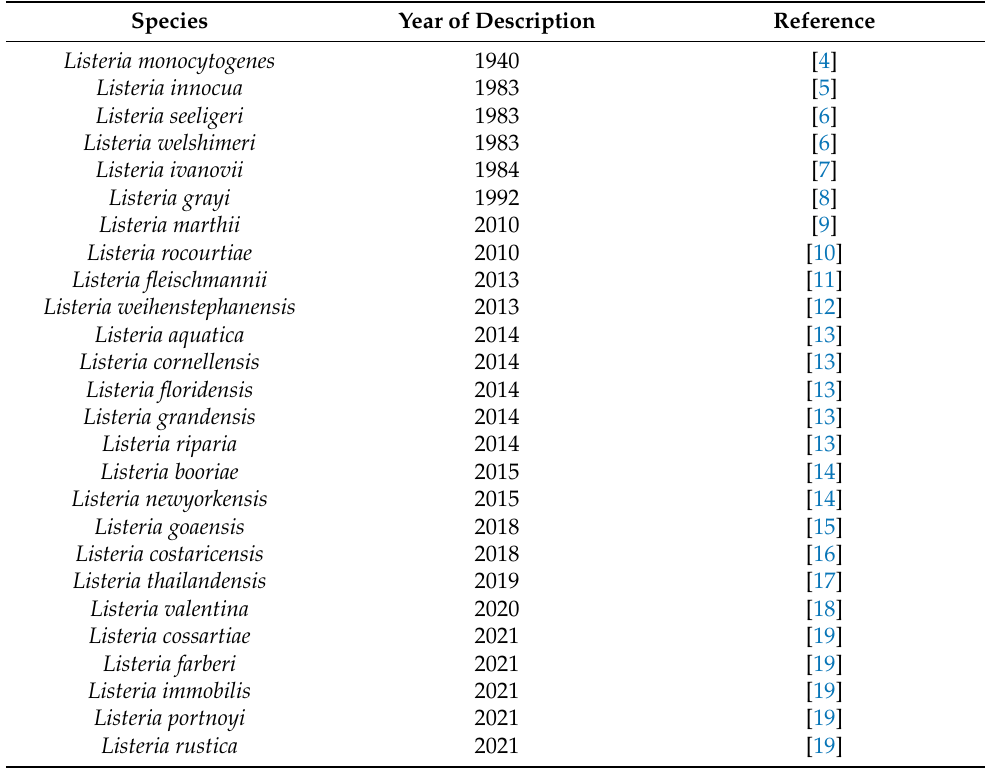
Table 1. Species in the genus Listeria . Adapted from Nwaiwu